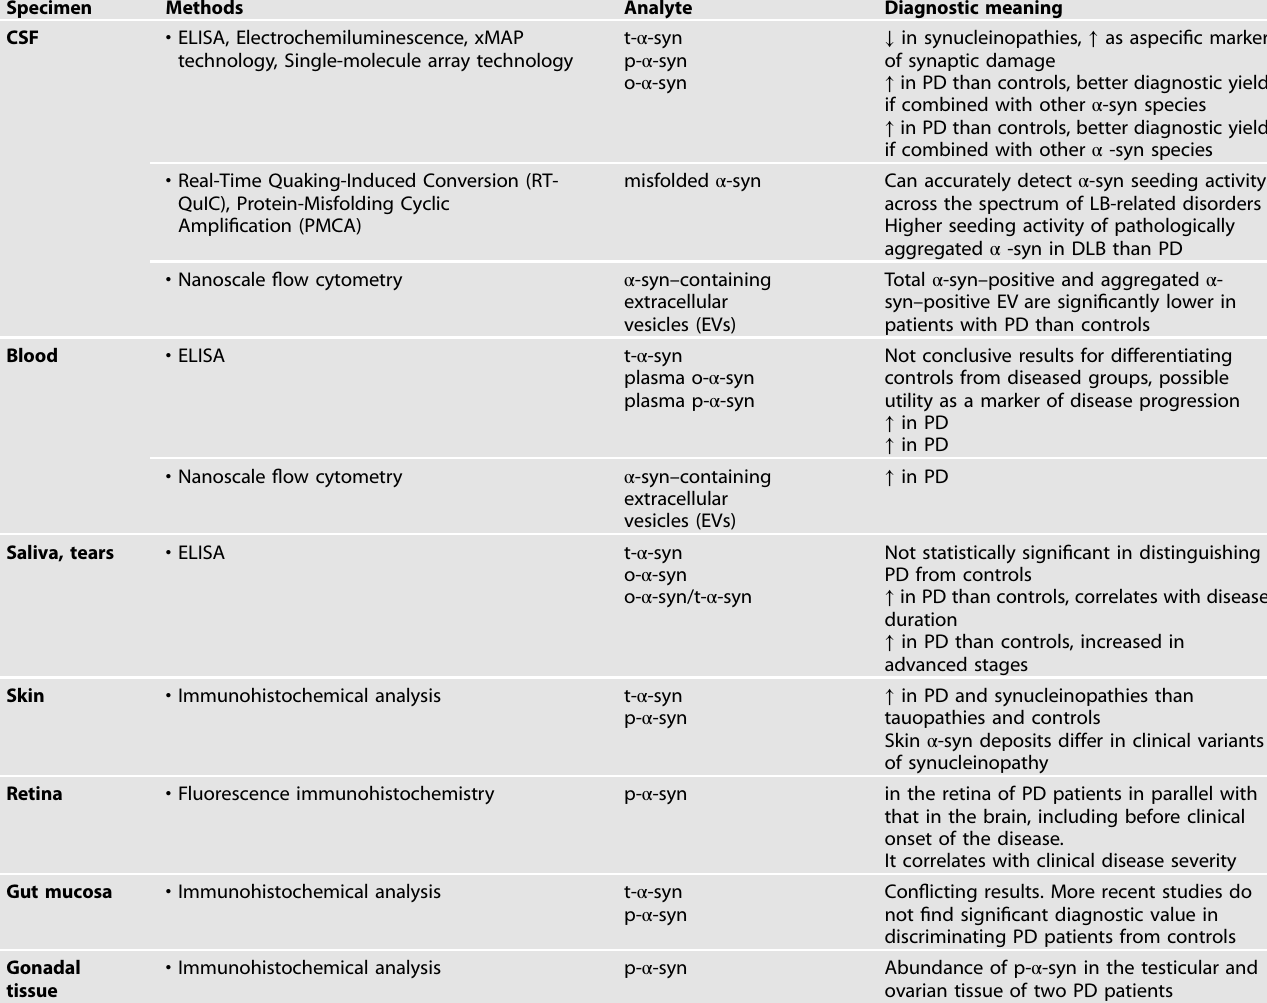
Table 2. Summary of techniques of synuclein species quanti fi cation in different specimens and fi ndings in PD.